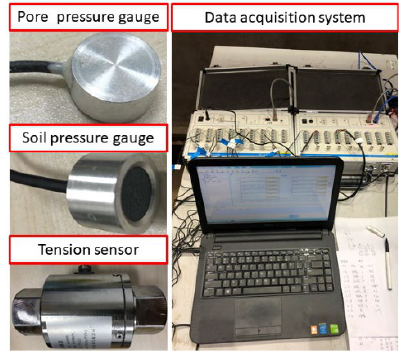
Figure 3. Sensor and data-acquisition system.